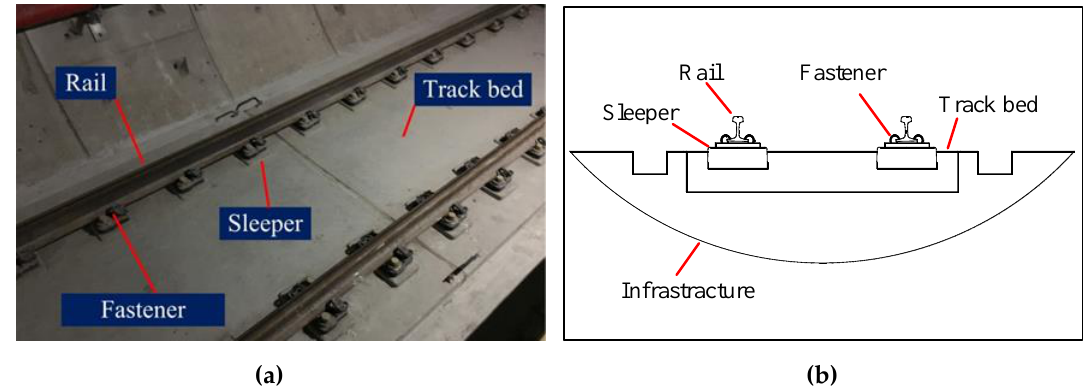
Figure 1. The monolithic track bed structure: ( a ) Photograph and ( b ) Sectional view.